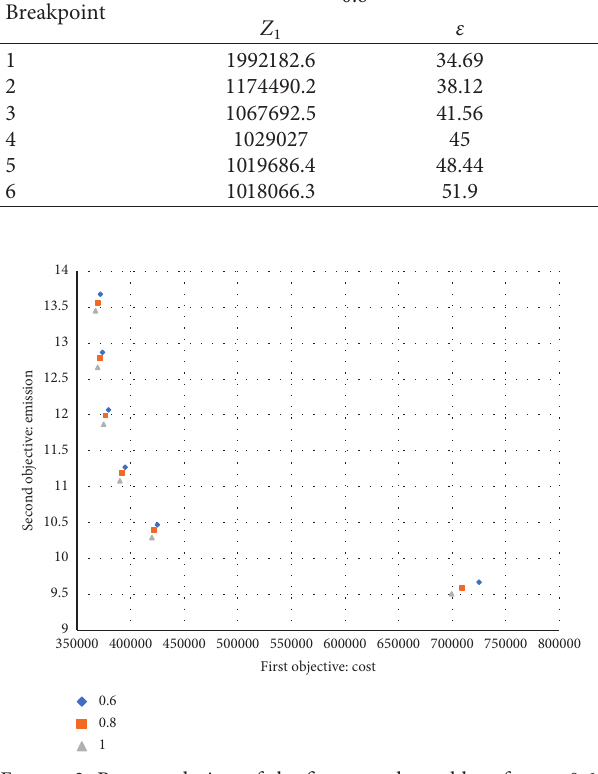
Figure 4: Pareto solution of the second sample problem for α � 0.6, 0.8, and